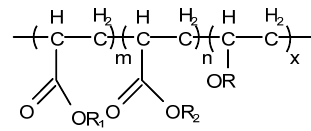
Figure 9. Structure of T912.